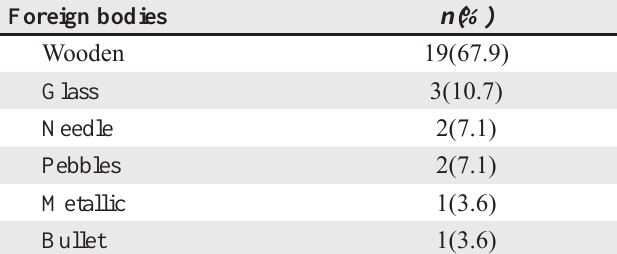
Table 1 : The distribution of foreign